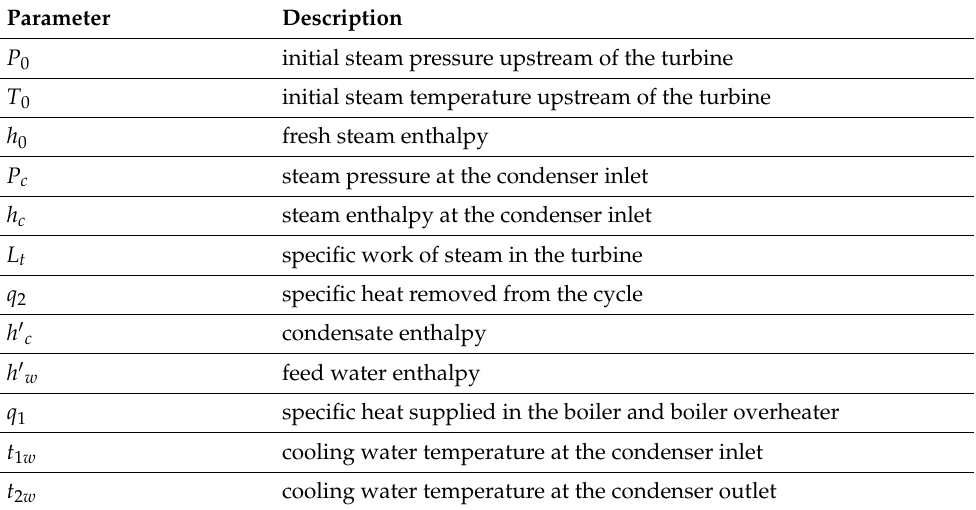
Table 5. Main thermodynamic parameters of a steam turbine plant.